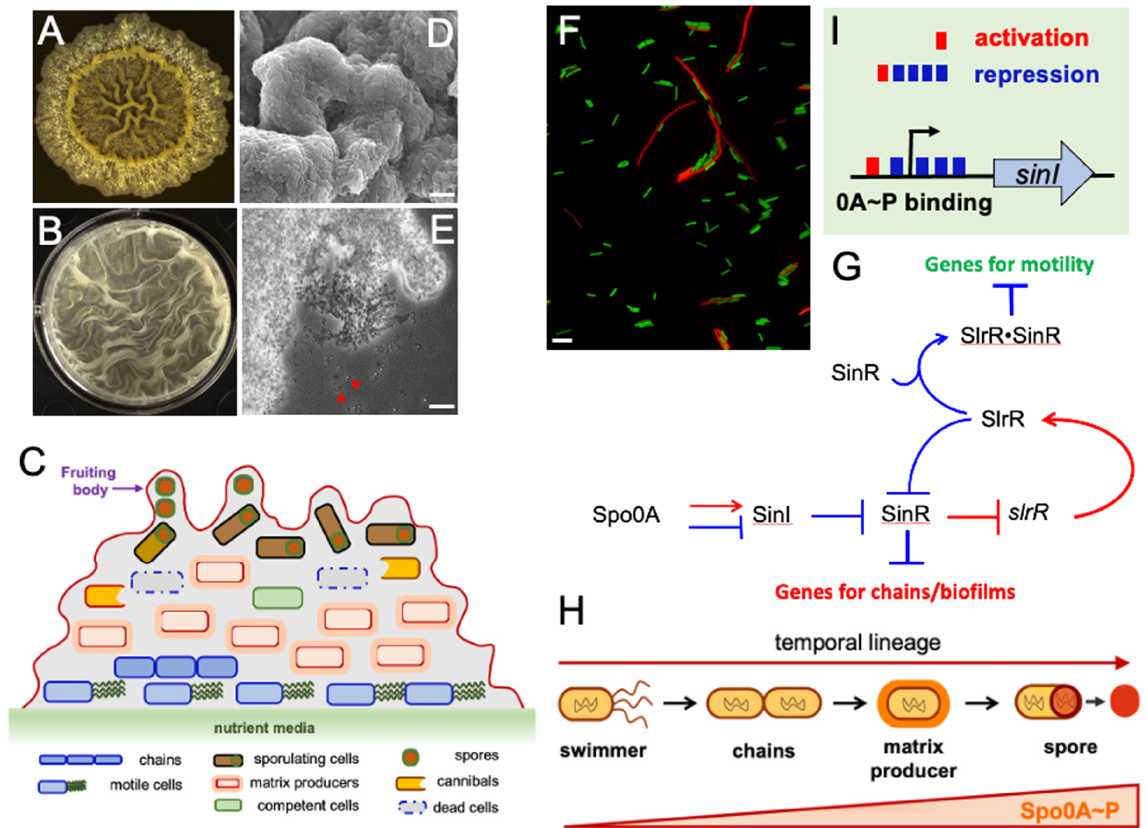
Figure 2. B. subtilis cell differentiation and mutually exclusive regulation in a multicellular community. ( A , B ) Colony ( A ) and pellicle ( B ) biofilms formed on a solid agar medium or at the air–liquid interface by B. subtilis . ( C ) A cartoon demonstrating the coexistence of multiple differentiated cell types in a B. subtilis biofilm. A fruiting body is an aerial projection rising from the surface of the biofilm. Spores are preferentially located at the tip of the fruiting bodies. ( D ) A scanning electron microscopy image of the fruiting body structure. Scale bar, 5 µ m. ( E ) A bright-field image of free spores associated with the tip of the fruiting body from a thin-section sample of a biofilm (images are provided by Angelini L). Arrows point to phase-bright spores. Scale bar, 25 µ m. ( F ) Differentiation of two mutually exclusive cell types, motile and sessile chained cells, in a population. Motile cells are producing GFP under the control of the promoter for the motility gene hag while chained cells are producing mKate2 under the control of the promoter for the biofilm matrix gene tapA . Scale bar, 5 µ m. ( G ) The epigenetic switch controlling the two mutually exclusive cell types in ( F ) consists of primarily three regulatory proteins, SinR, SinI, and SlrR. SinR is a biofilm repressor, Sin I is an antagonist protein of SinR whose gene is activated by Spo0A~P (0A~P). SlrR is another SinR counteracting protein. SlrR and SinR form a double negative feedback loop in which SinR represses the gene slrR while the SlrR protein antagonizes SinR, similar to SinI. A heterocomplex of SinR • SlrR represses motility and cell separation genes [24]. ( H ) A temporal lineage of B. subtilis cell development. 0A~P levels are a key determinant of cell differentiation. Intermediate levels of 0A~P drive the transition of motile cells to chains of cells also expressing matrix genes and shut down motility genes indirectly through the SinI-SinR-SlrR epigenetic switch [24]. High levels of 0A~P activate hundreds of genes involved in sporulation, thus leading some matrix producers to become sporulating cells while simultaneously turning off matrix production. ( I ) The regulatory region of sinI contains both an activator and multiple operators of 0A~P, whose sequences imperfectly match the consensus 0A~P binding site. This allows both activation of sinI by intermediate levels of 0A~P and repression of sinI when the 0A~P concentration reaches high levels [35] .